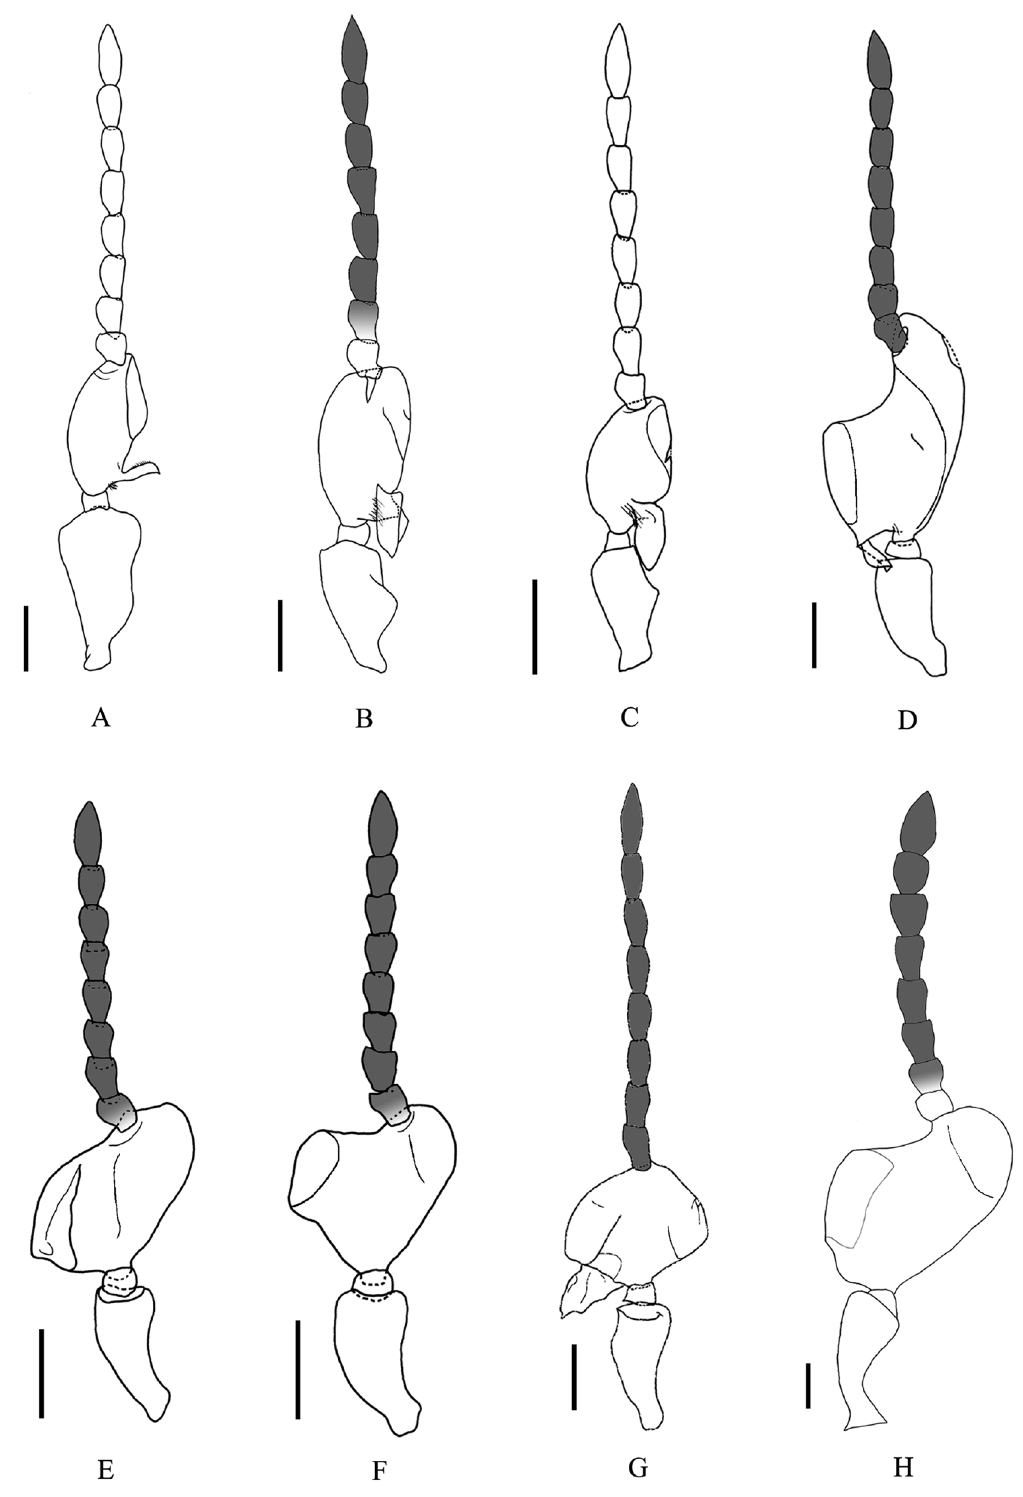
Fig. 4. Right antennae of Intybia spp., ♂. A . Intybia histrio (Kiesenwetter, 1874). B . I. tsushimensis (Satô & Ohbayashi, 1968). C . I. donan sp. nov. D . I. pelegrini pelegrini (Pic, 1910). E . I. niponica (Lewis, 1895). F . I. takaraensis (Nakane, 1955). G . I. kishiii (Nakane, 1955). H . I. kawasakii (Nakane, 1956). Scale bars = 0.2